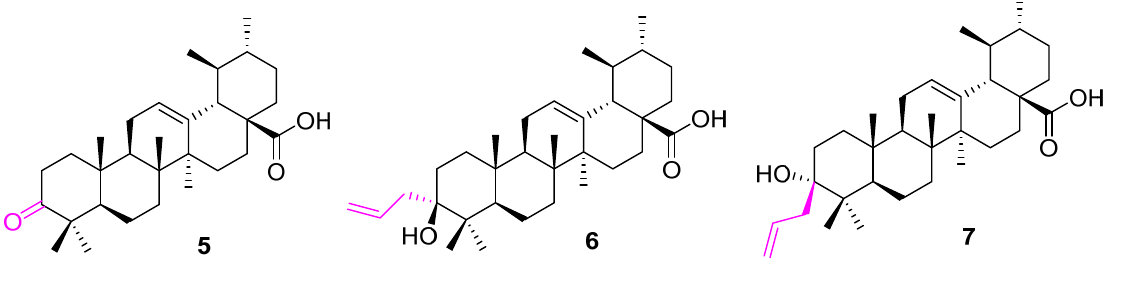
Figure 6. Structure of 5 , 6 , 7 .